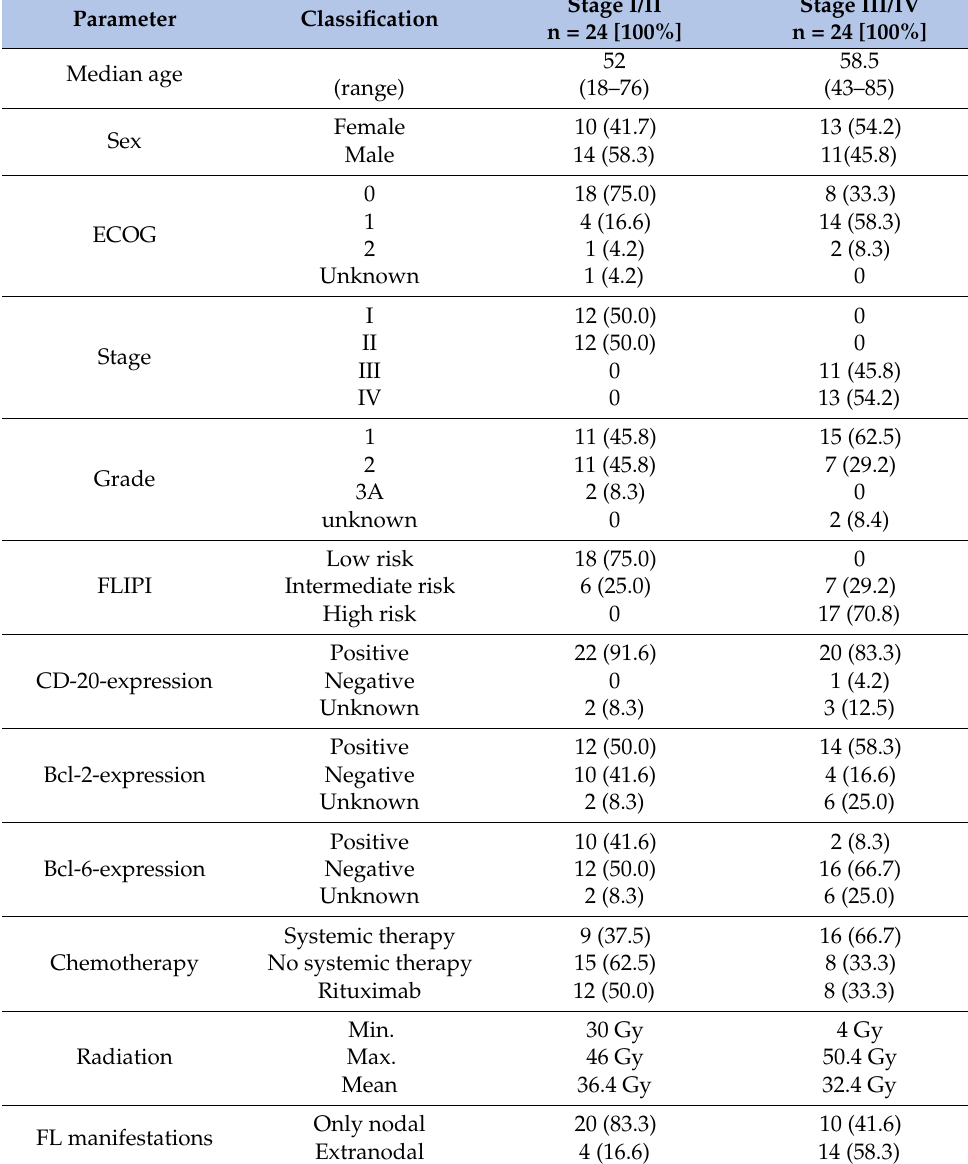
Table 2. Patients age, gender and lymphoma characteristics.